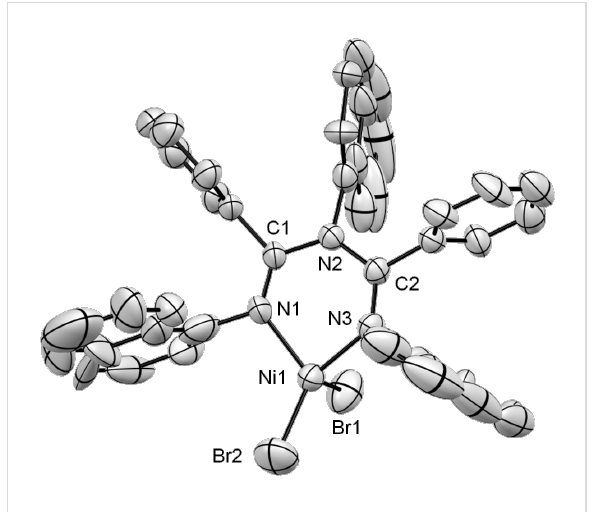
Figure 5: ORTEP drawing of 12 . Thermal ellipsoids are set at 35% probability level. Hydrogen atoms and cocrystallized CH 2 Cl 2 are omitted for clarity. Selected bond lengths [Å] and angles [°] are as follows: C(1)–N(1) 1.277(11), C(1)–N(2) 1.393(11),